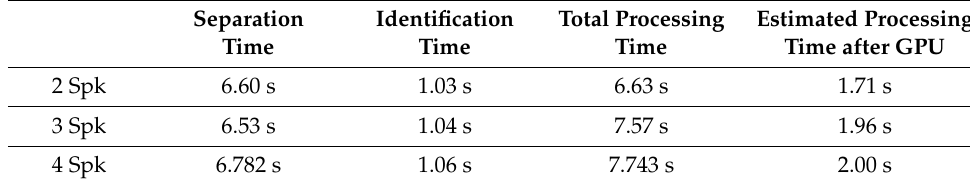
Table 2. Process time for different numbers of mixed